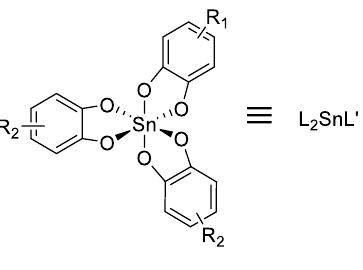
Figure 39. Structure of the catechol tin compounds.